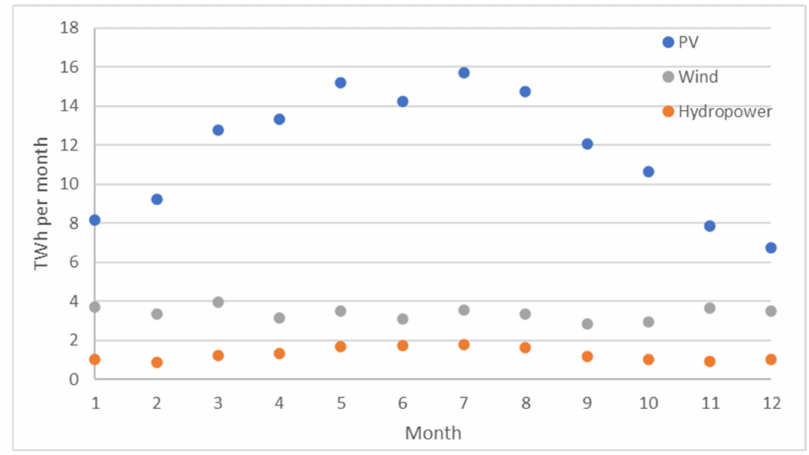
Figure 15. Incremental electricity generation in 2050 compared with 2019 over the course of the year for